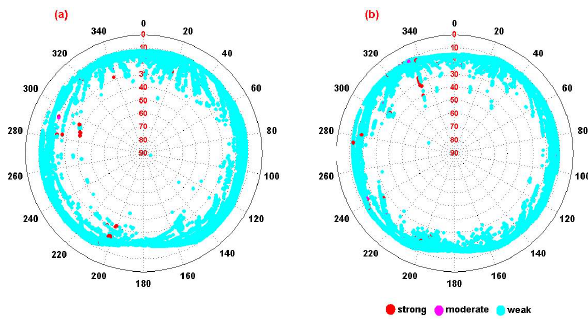
Fig. 3. The elevation–azimuth plot of non-ionospheric scintillation occurrences for (a) Bandung and (b) Pontianak. Strong (S4>0.8), moderate (0.5<S4<0.8), and weak (0.2<S4<0.5) scintillation events are indicated by the red, magenta, and cyan colours, re- spectively. The azimuth angle is measured clockwise from the geo- graphic north.